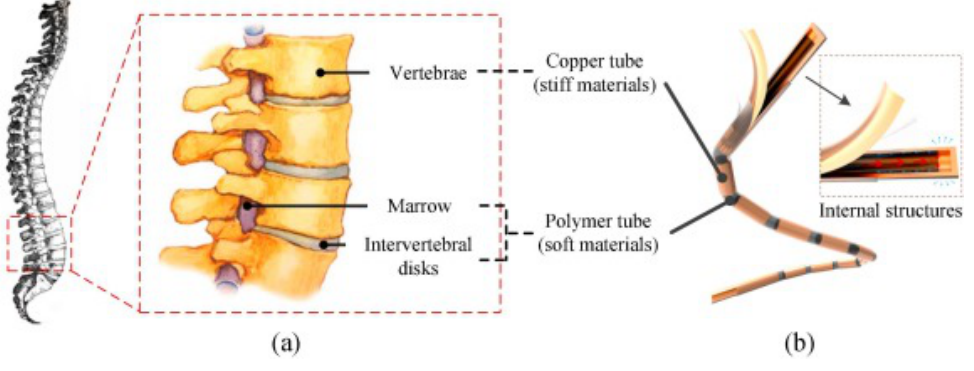
Figure 5. Schematic of human spine ( a ) and a bionic flexible heat pipe ( b )